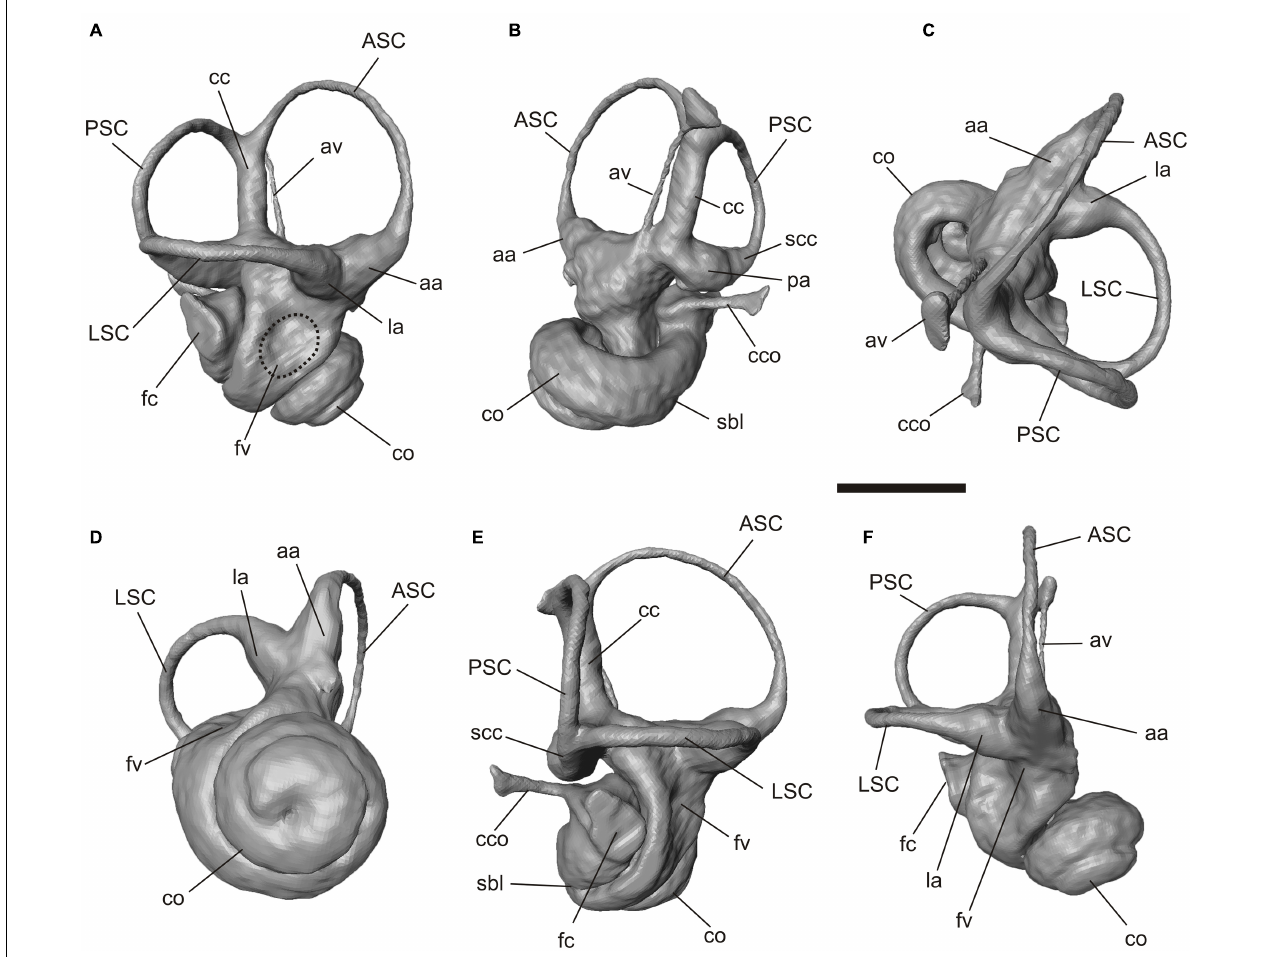
FIGURE 5 | Virtual 3D reconstruction of the right bony labyrinth of Palaeolagus haydeni (FMNH PM9476). (A) lateral, (B) medial, (C) dorsal, (D) ventral, (E) posterolateral and (F) anterolateral views. Abbreviations: aa, anterior ampulla; ASC, anterior semicircular canal; av, aquaeductus vestibuli; cc, crus commune; cco, canaliculus cochleae; co, cochlea; la, lateral ampulla; fc, fenestra cochleae; fv, fenestra vestibuli; LSC, lateral semicircular canal; pa, posterior ampulla; PSC, posterior semicircular canal; sbl, secondary bony lamina; scc, secondary crus commune. Scale bar = 2